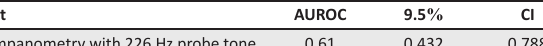
TABLE 3 : Area under the curve for tympanometry with 226 Hz and pure tone audiometry. Test AUROC 9.5 % CI Tympanometry with 226 Hz probe tone